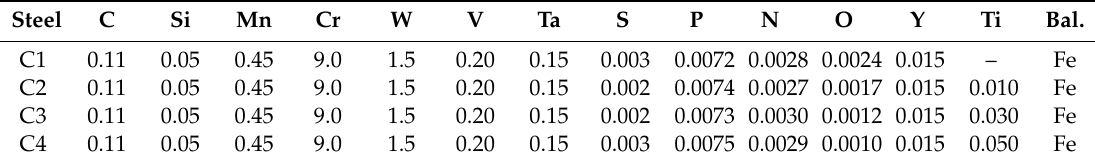
Table 1. Chemical composition of the analyzed steel alloys